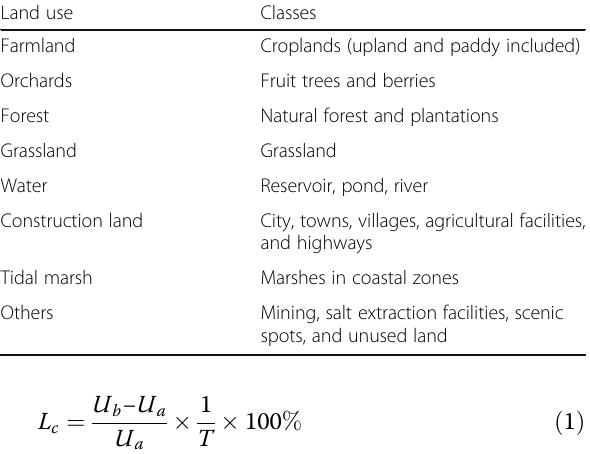
Table 2 Land use classes